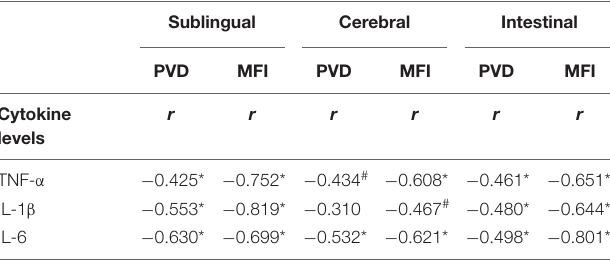
TABLE 1 | Correlations between microcirculatory parameters and serum cytokine levels. Sublingual